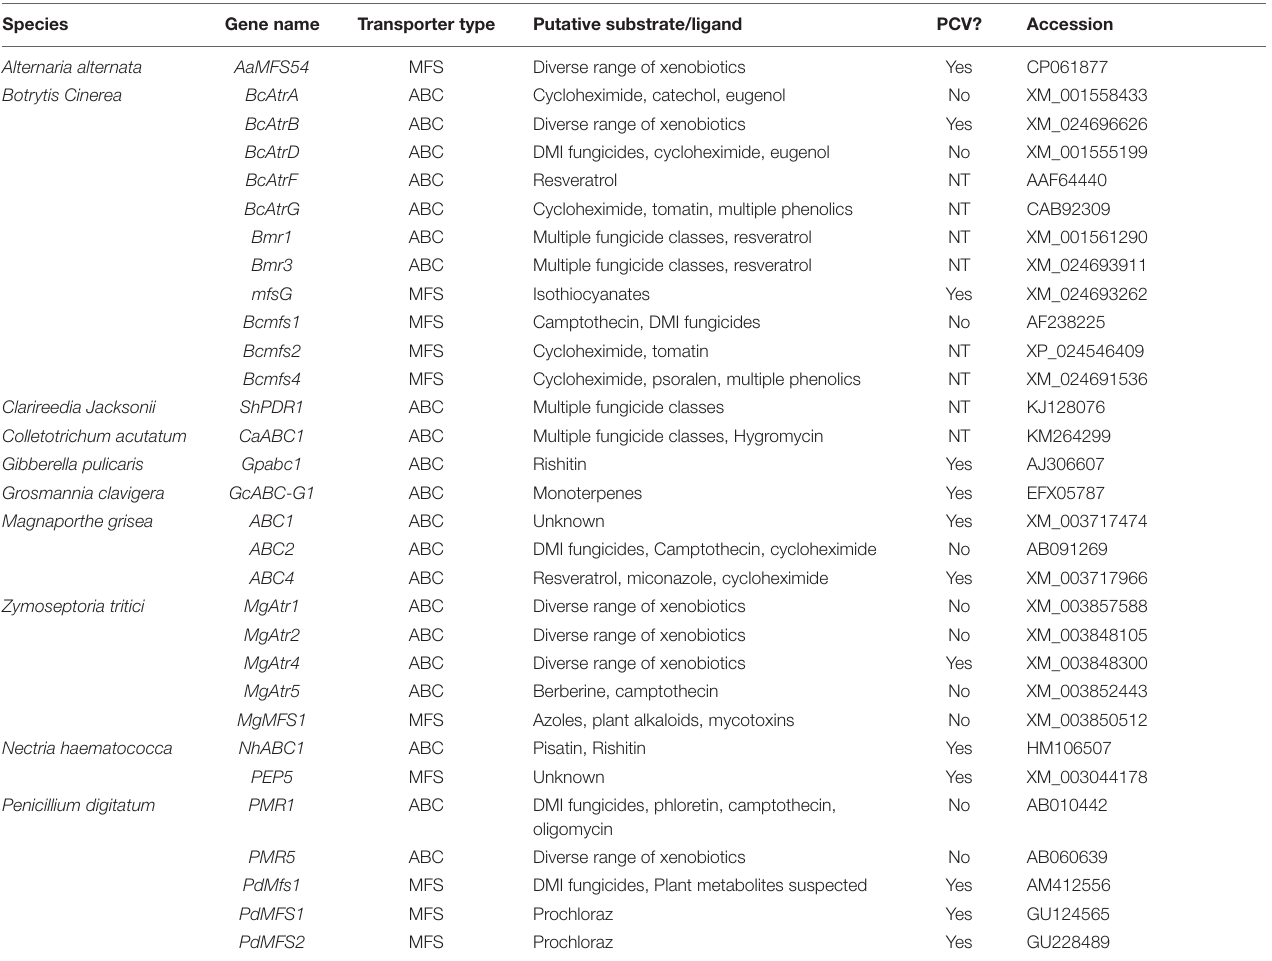
TABLE 4 | Putative efflux transporters involved in fungal tolerance to plant defense